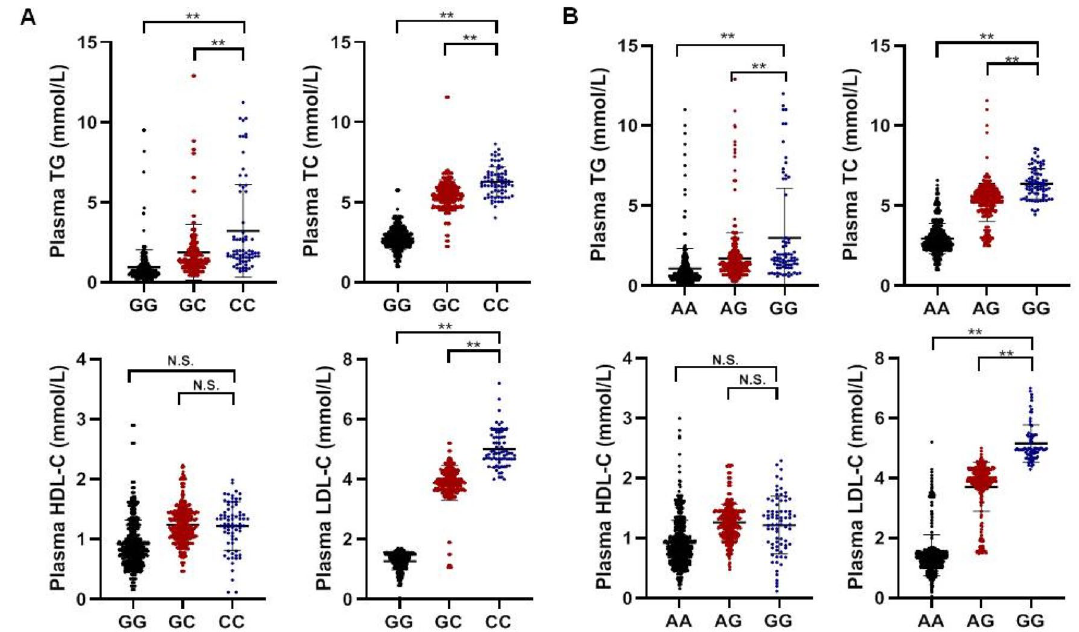
Figure 1. ( A ) Influence of the RNF145 gene rs17056583 on the lipid profile. n = 1396. Values are means ± SD. ( B ) Influence of the RNF145 gene rs12188266 on the lipid profile. n = 1396. Values are means ± SD. *P < 0.05, **P < 0.001, N.S. indicates no significance.